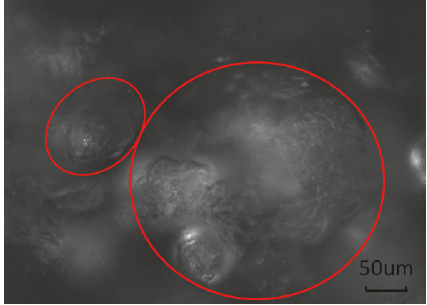
Figure 5: Hydrate particles (marked in the red circles) in gas-liquid multiphase system.